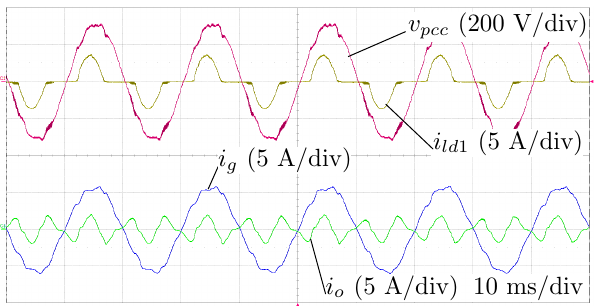
Figure 12. Experimental results when the voltage support loop is enabled, I ∗